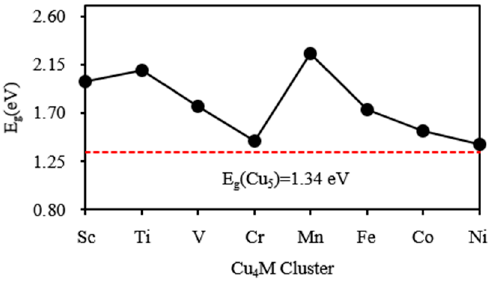
Figure 4. The HOMO-LUMO energy gaps of the ground state Cu 4 M (M = Sc-Cu) clusters.